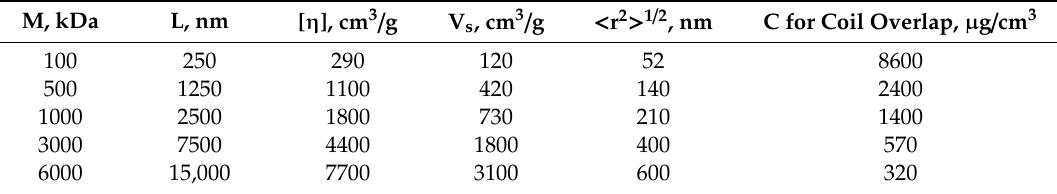
Table 1. Limiting viscosity number and hydrodynamic size of hyaluronic acid with various molecular weights [40].